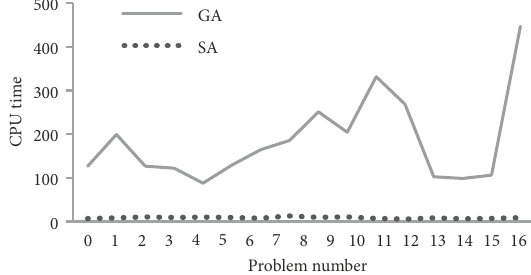
Figure 15. Mean and interval plots for the RPD of the GA and the SA algorithms